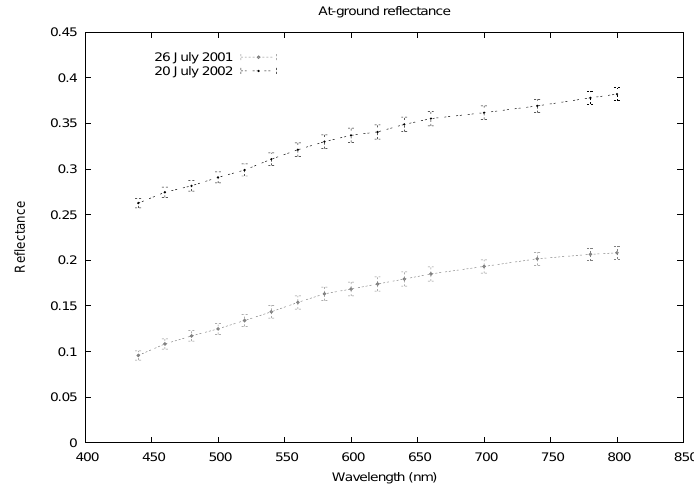
Figure 2 . The reflectance of the surface, which meets the requirements of the isotropy of the BRDF and is spectrally homogeneous.